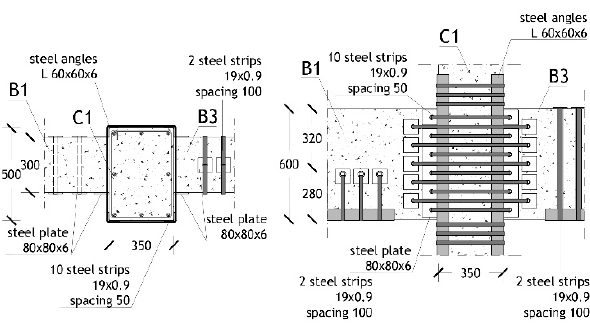
Figure 25. ACM-strengthened ground storey beam-to-column joint N.